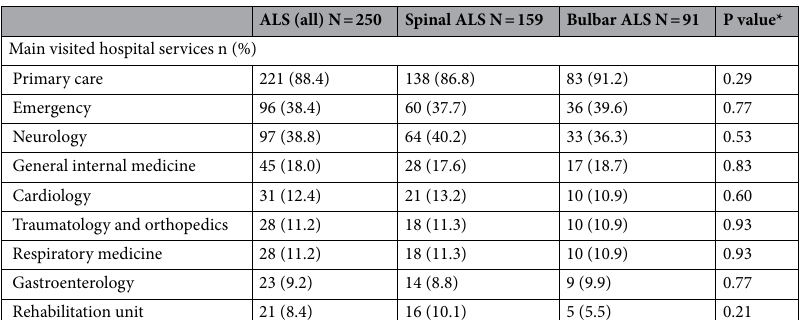
ALS (all) N = 250 Spinal ALS N = 159 Bulbar ALS N = 91 P value* Main visited hospital services n